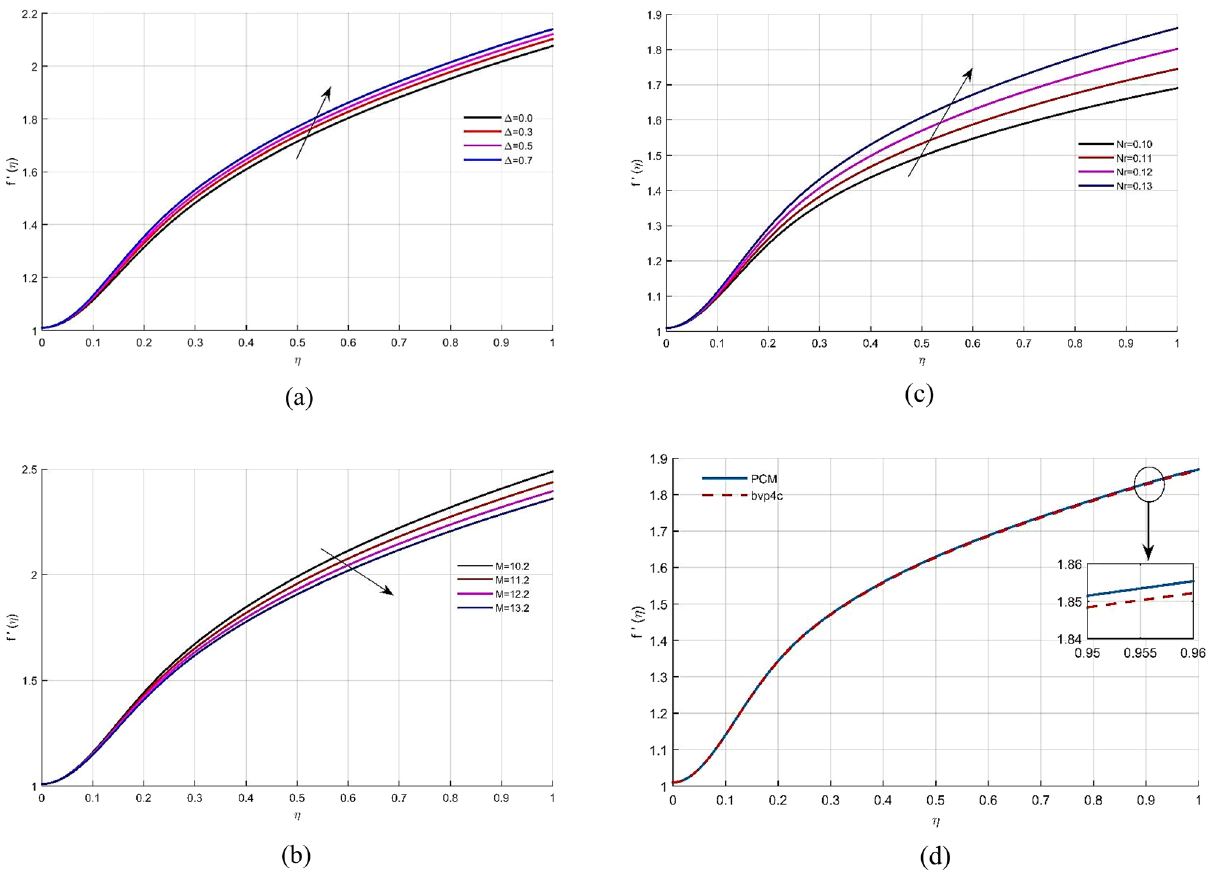
Figure 2. (a – d) The impact of (cid:31) , Mr and Nr on non-dimensional velocity field f ′ (η) . ( d ) Comparison of solution obtained by PCM and bvp4c